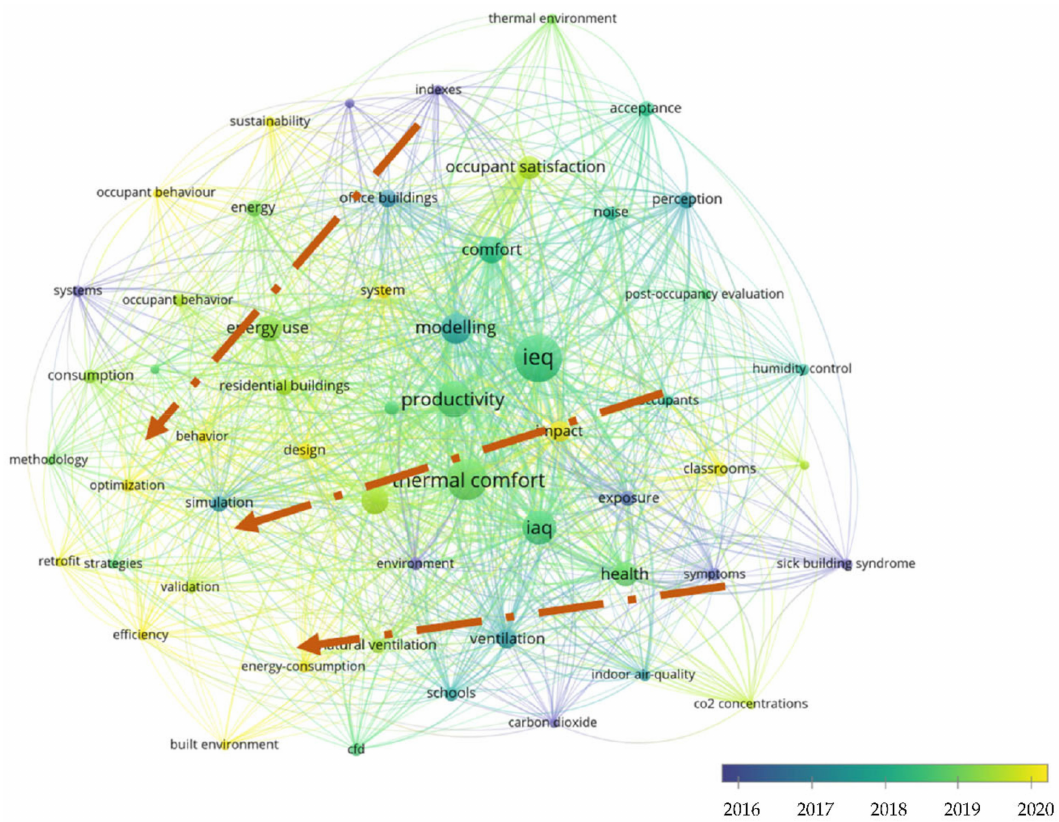
Figure 6. High-frequency keywords